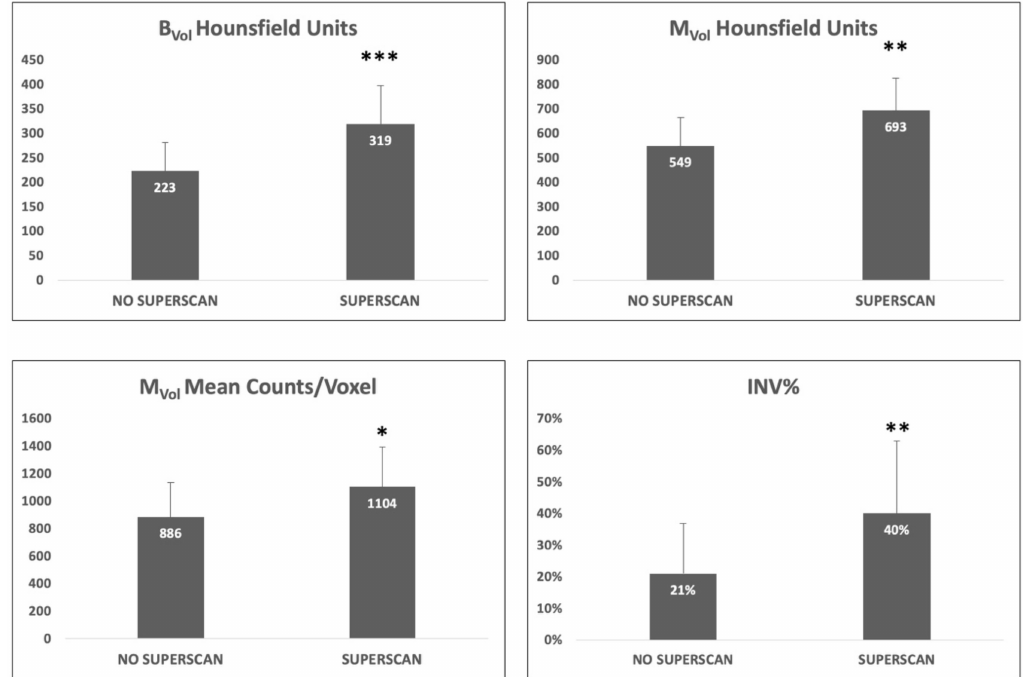
Figure 2. Comparison between superscan and non-superscan patients. Superscan subjects showed a higher density in trabecular bone volume (B Vol ) as well as in metastases volume (M Vol ) (upper panels). A higher counting rate was observed in the M Vol of superscan patients (bottom left). Finally, percent of trabecular bone space invaded by metastatic lesions was higher in the superscan subjects (bottom right). * p < 0.05, ** p < 0.01, *** p < 0.001. INV% Percent of bone invaded by metastases (M Vol / B Vol